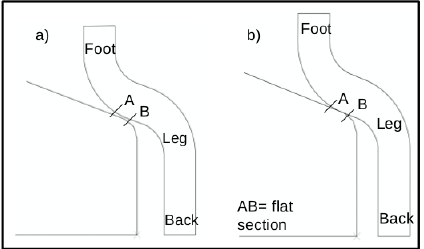
Figure 4: Assembling process of V-band retainer in axisymmetric finite element model, a) un-assembled, b) assembled (T-bolt nut